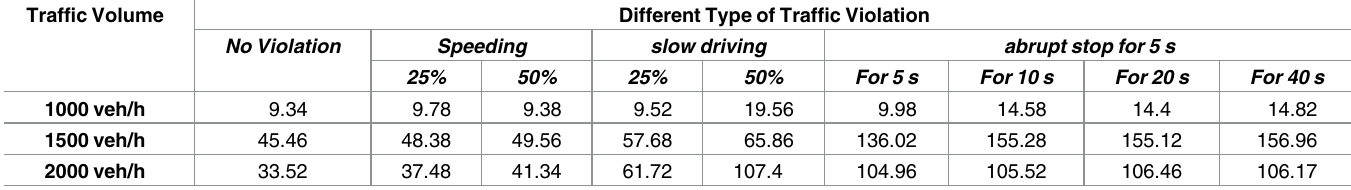
Table 5. The number of high-risk status before and after adding vehicle violations for different traffic conditions. Traffic Volume